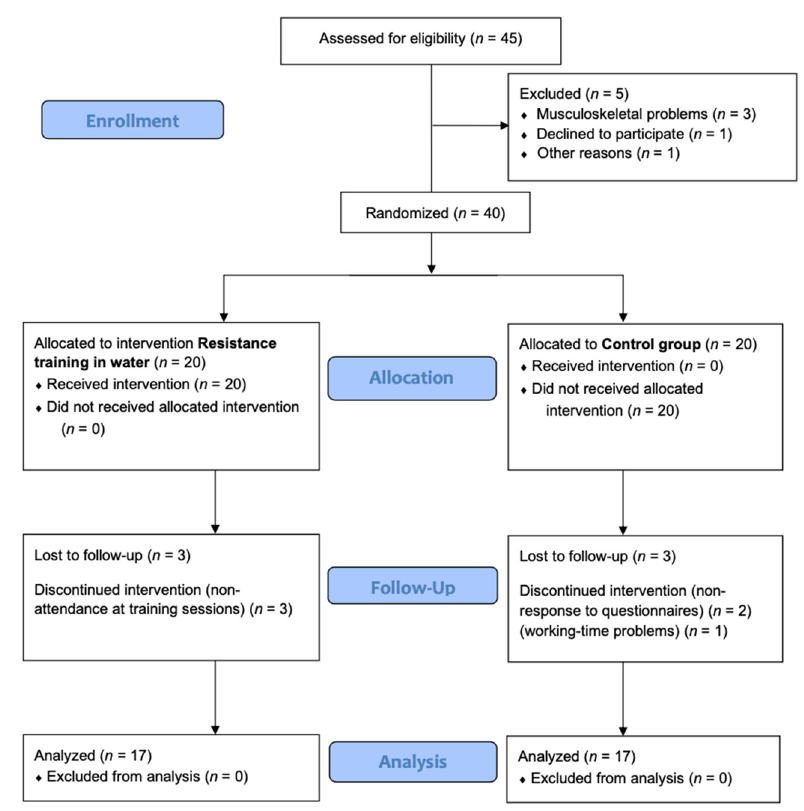
Figure 1. Consort 2010 flow diagram.